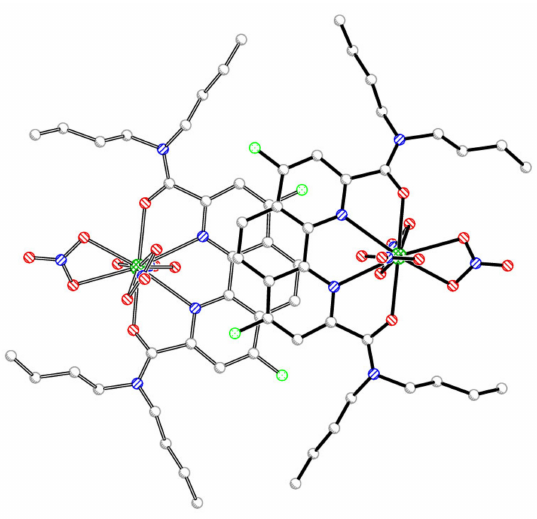
Figure 9. The stacking dimer in the crystal of 7a • Ln(NO 3 ) 3